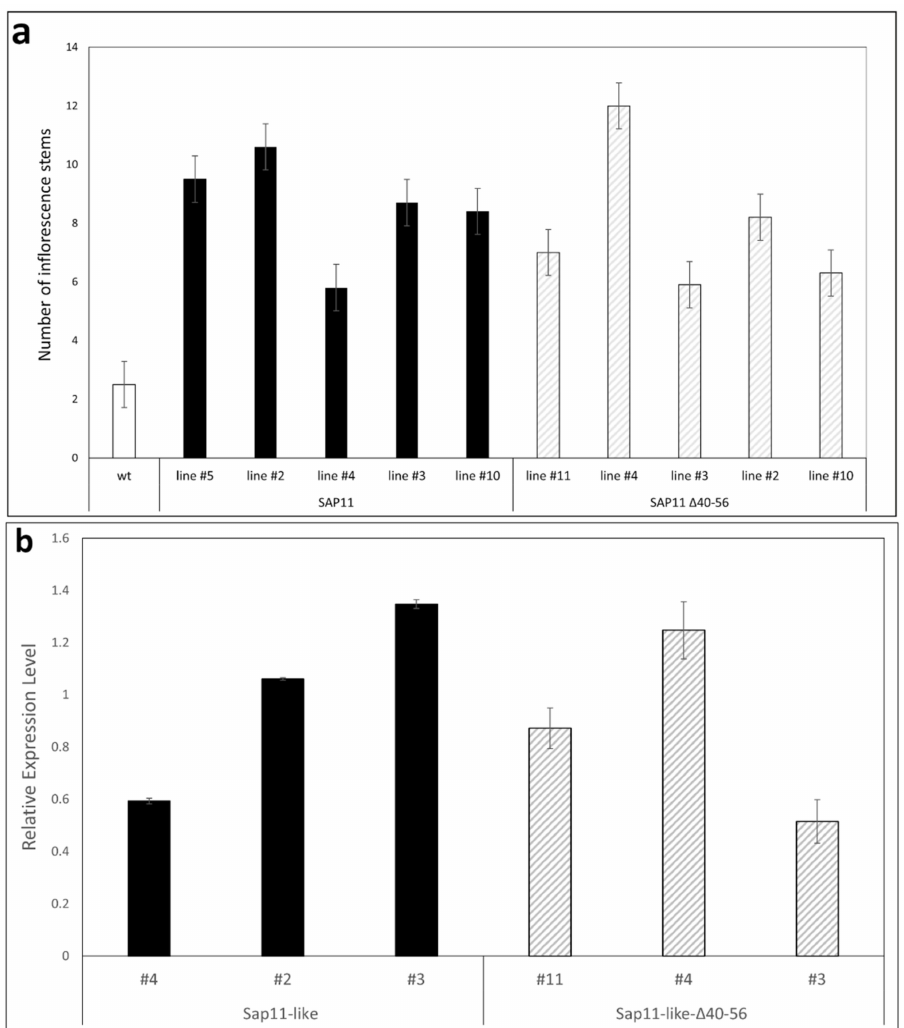
Figure 5. ( a ) Number of primary stems developed by transgenic A. thaliana lines compared to the wt Col-0 plant. ( b ) Relative expression levels of transgenes of transgenic lines compared to the geometric average of glyceraldehyde-3-phosphate dehydrogenase ( GAPDH ) and protein phosphatase 2 ( PP2A ). All values show a p -value lower than 0.05 in